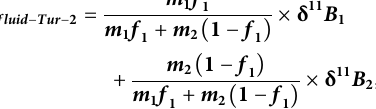
Frontiers in Earth